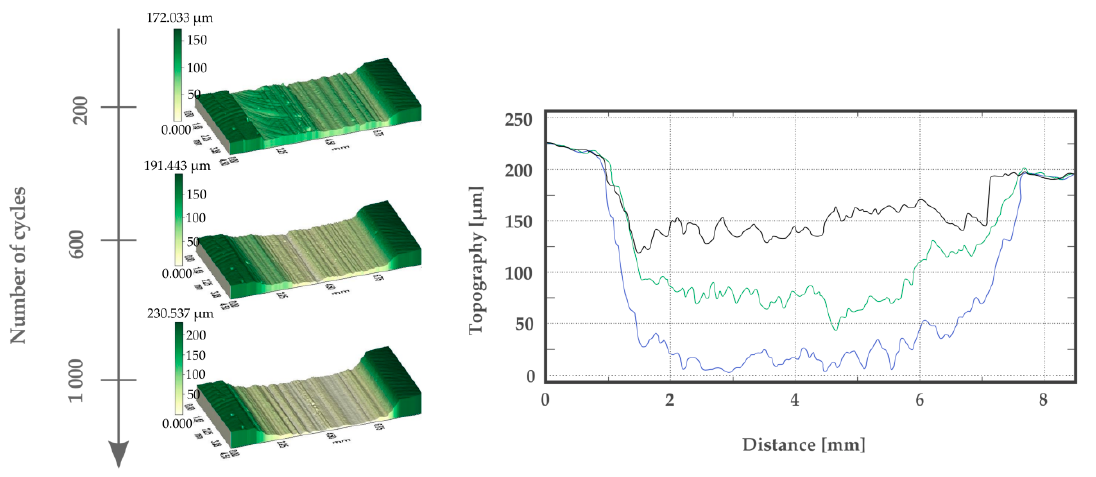
Figure 10. Topography and profiles of MWCNTs 0.25 wt.% sample after 200, 600, and 1000 wear cycles.